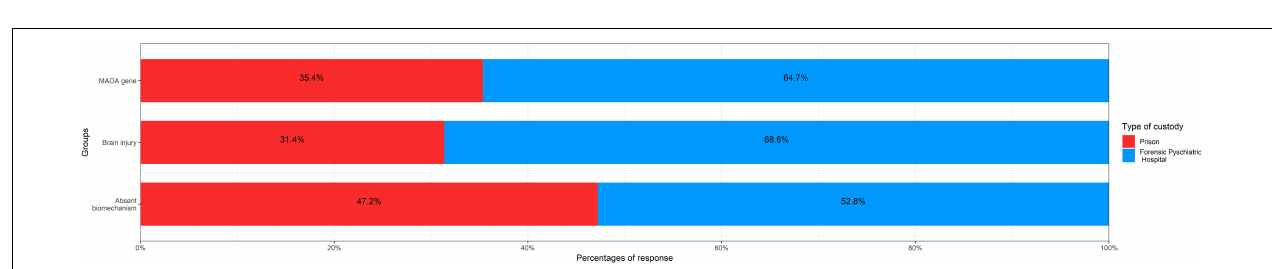
from school until the university entrance diploma ( Table 1 ).